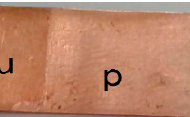
Figure 9. A photograph of a sample of metallic copper sheet after electrochemical dissolution in choline chloride-based IL after being held at +0.18 V for 10 min at 20 °C, unpolished (u) and polished chloride-based IL after being held at + 0.18 V for 10 min at 20 ◦ C, unpolished (u) and polished (p).